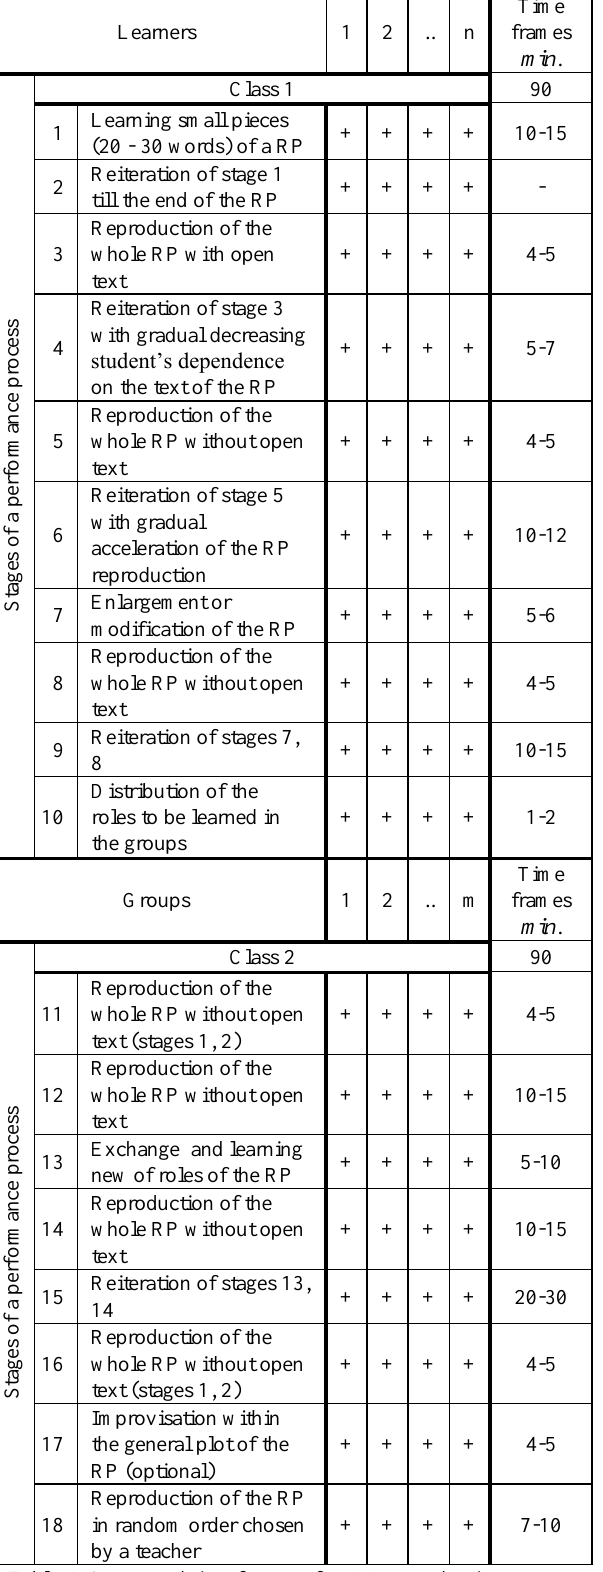
Table 4. Stages and time frames of an RP reproduction process